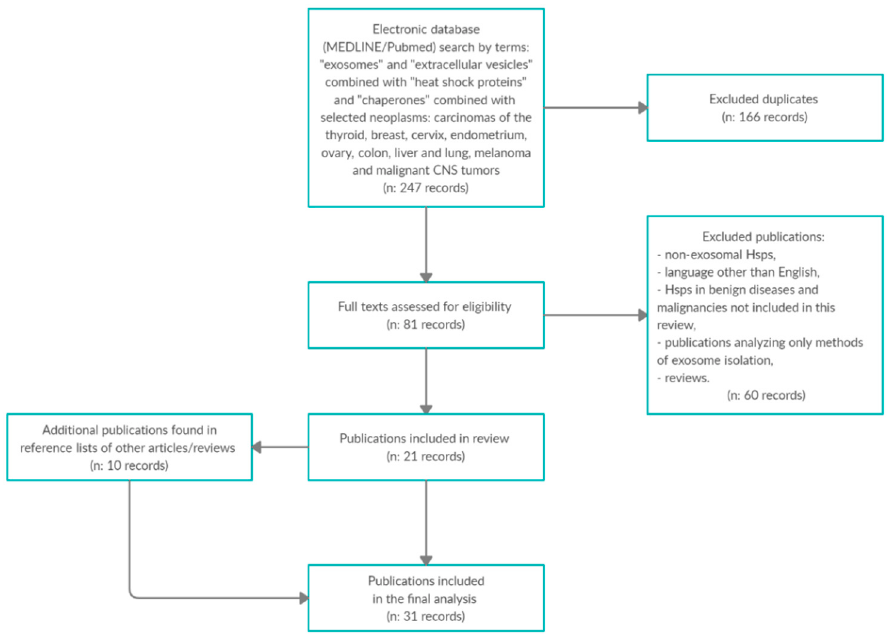
Figure 1. Summary of the methodology of the exosomes’ determination and the clinical values of reviewed studies.